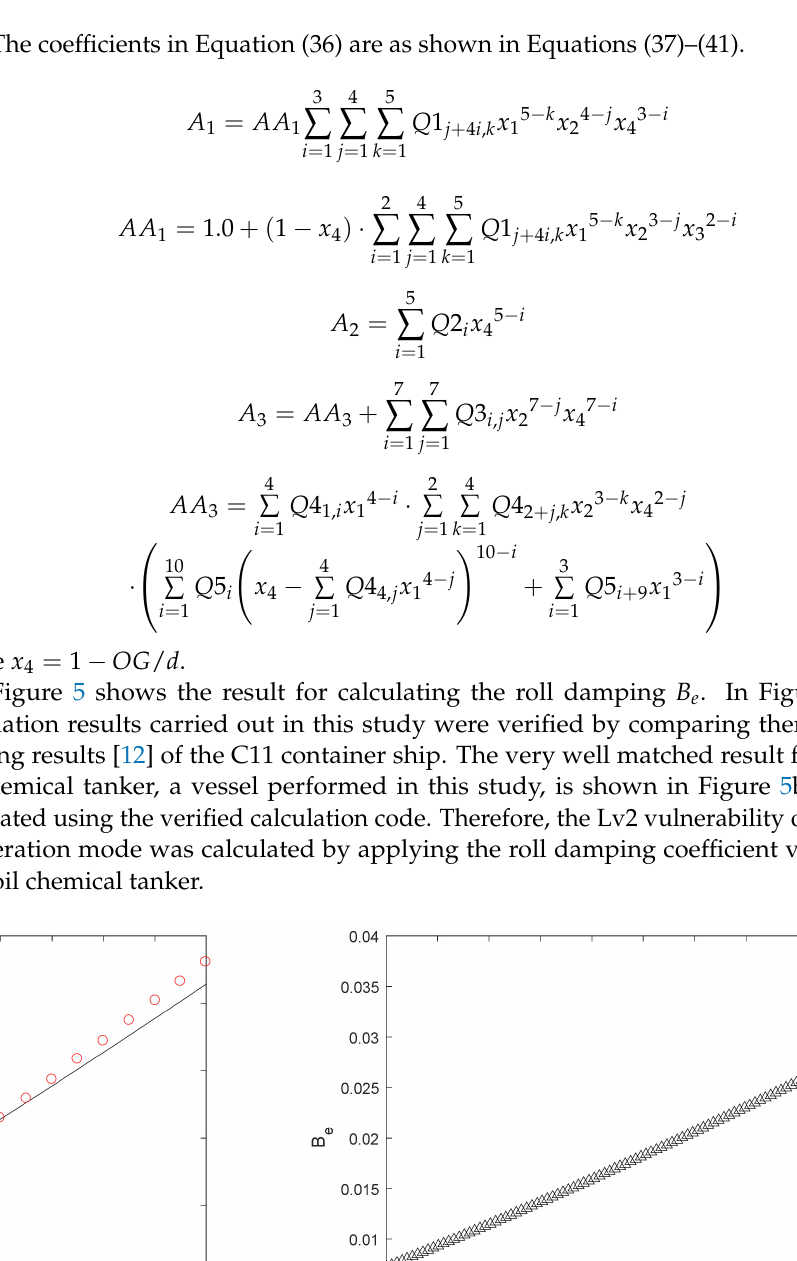
: [5]), ( b ) 13 K oil chemical tanker ( ∆ (cid:35)